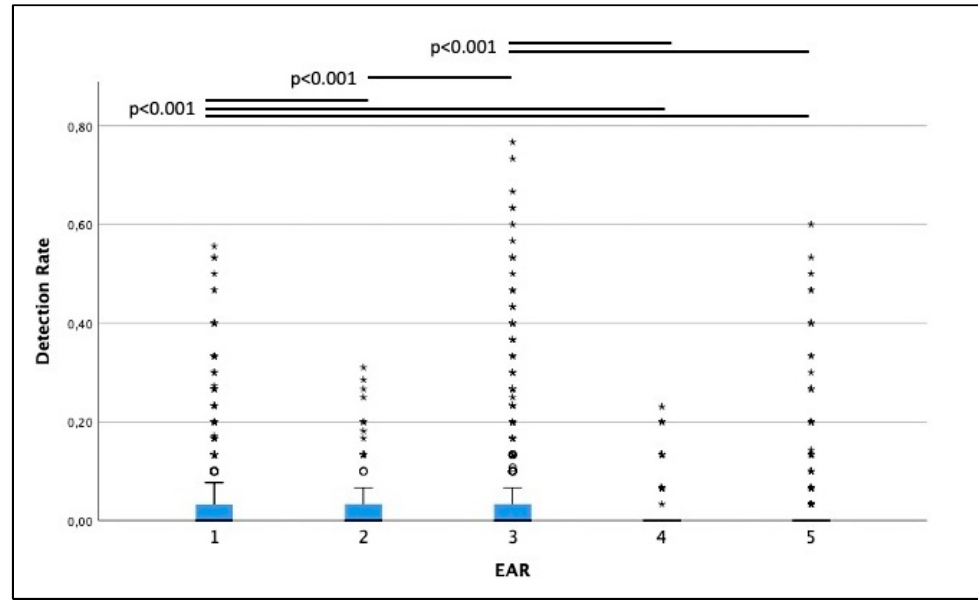
Figure 6. Boxplot of the detection rate at daytime and nighttime. The upper and lower sides of the box represent the first and third quartiles of the sample distribution and shows the width of the middle half of the distribution. The line inside the box instead represents the median. The whisker, the segment that starts from the box and extends upward, indicates the dispersion of values below the first quartile and above the third quartile that are not classified as outliers. Outliers are identified as small circles for “out” values and as stars for “extreme” values. Black bars represent the statistical difference between daytime (generally from 07:00 to 20:00) and nighttime (generally from 20:00 to 07:00).